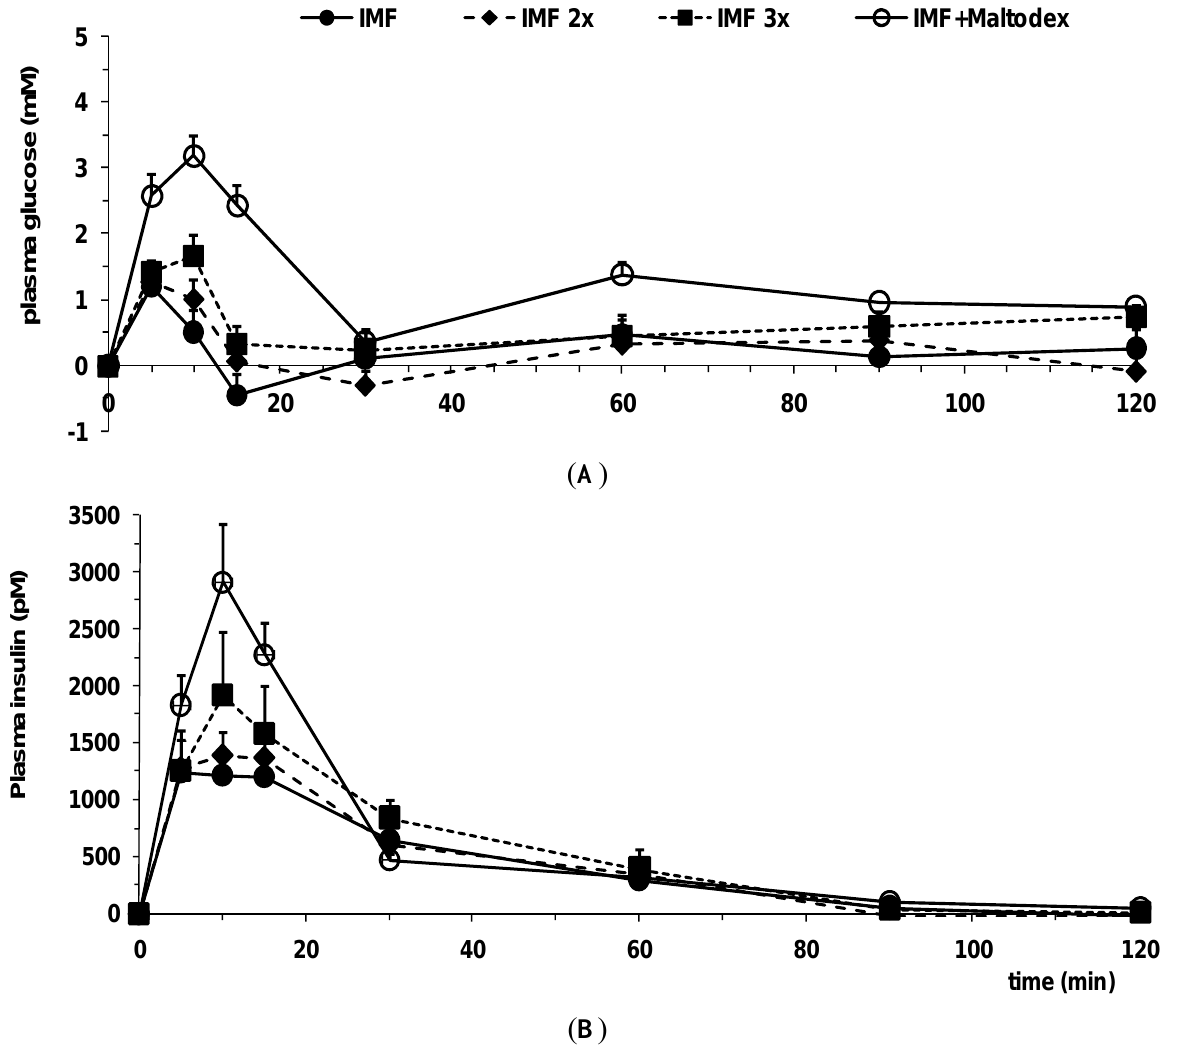
Figure 5. Incremental postprandial plasma glucose ( A ) and insulin ( B ) levels in response to administration of various aqueous IMF loads ( n = 7–12). IMF, infant milk formula.